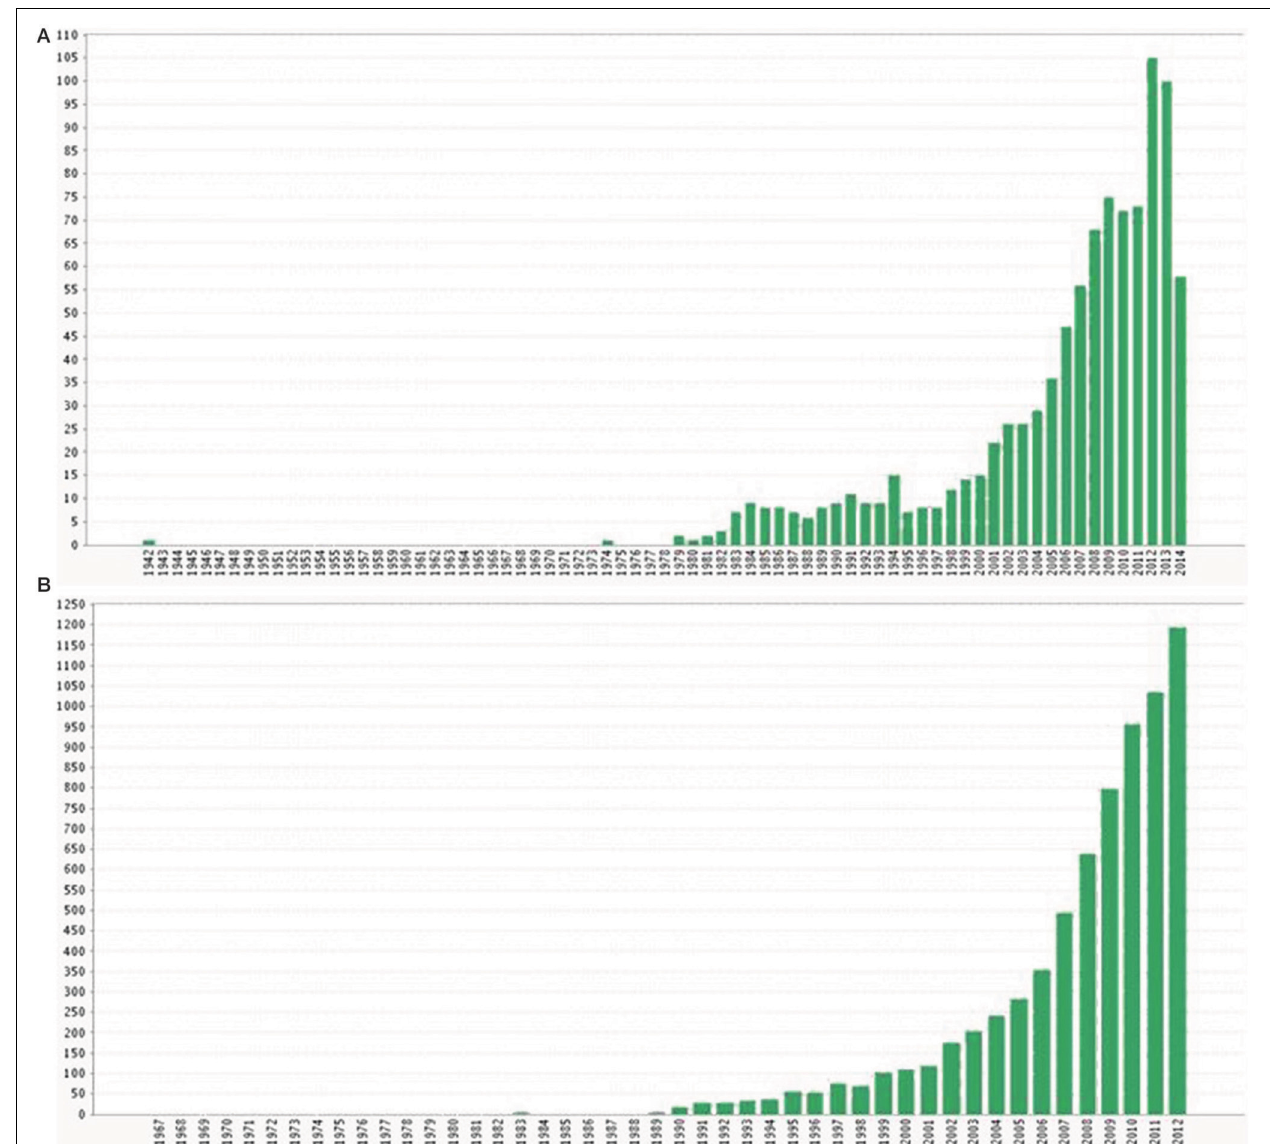
FIGURE 1 | Number of publications (including papers, reports, books, meetings and any scientific document available) using the ISI web of knowledge about a) climate and seabirds since 1942 to 2014 and (B)